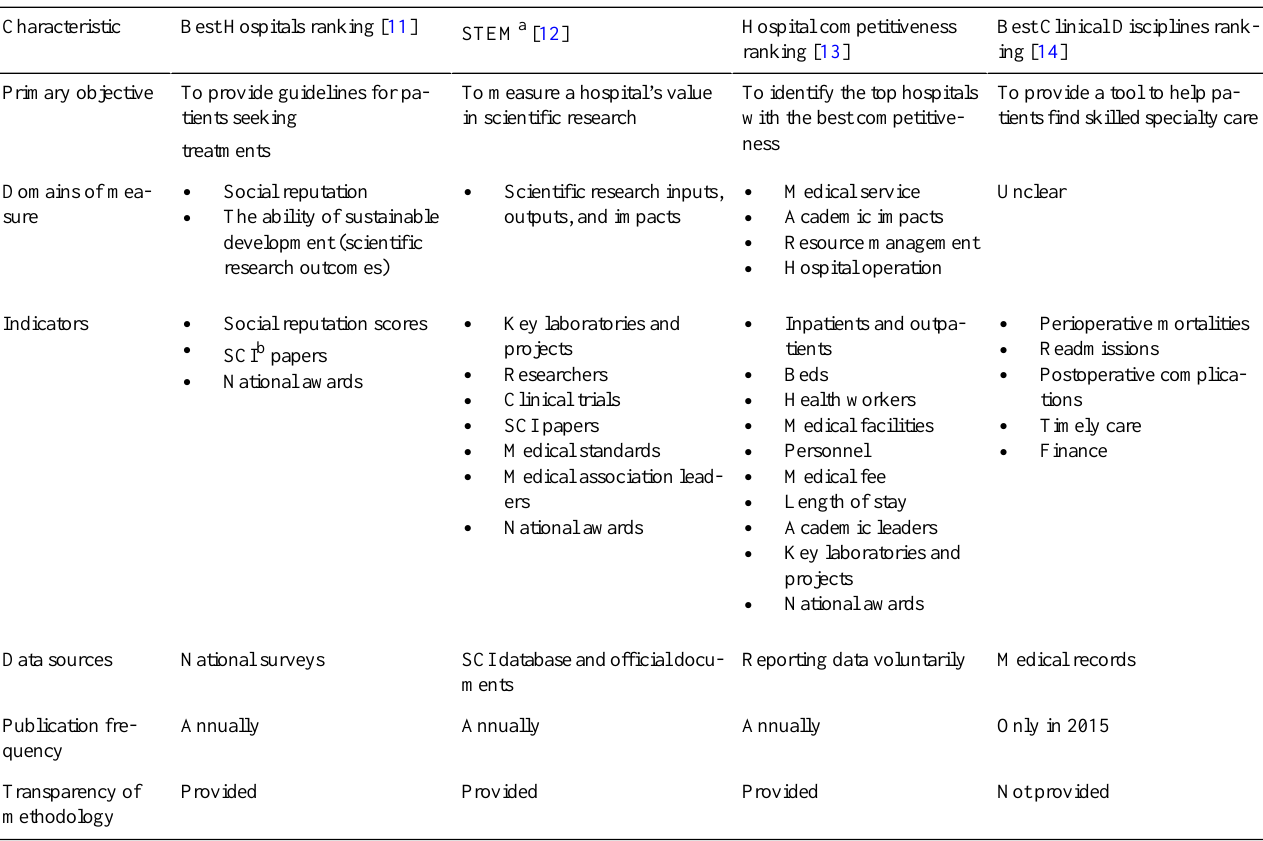
Table 1. Overview of China’s hospital ranking